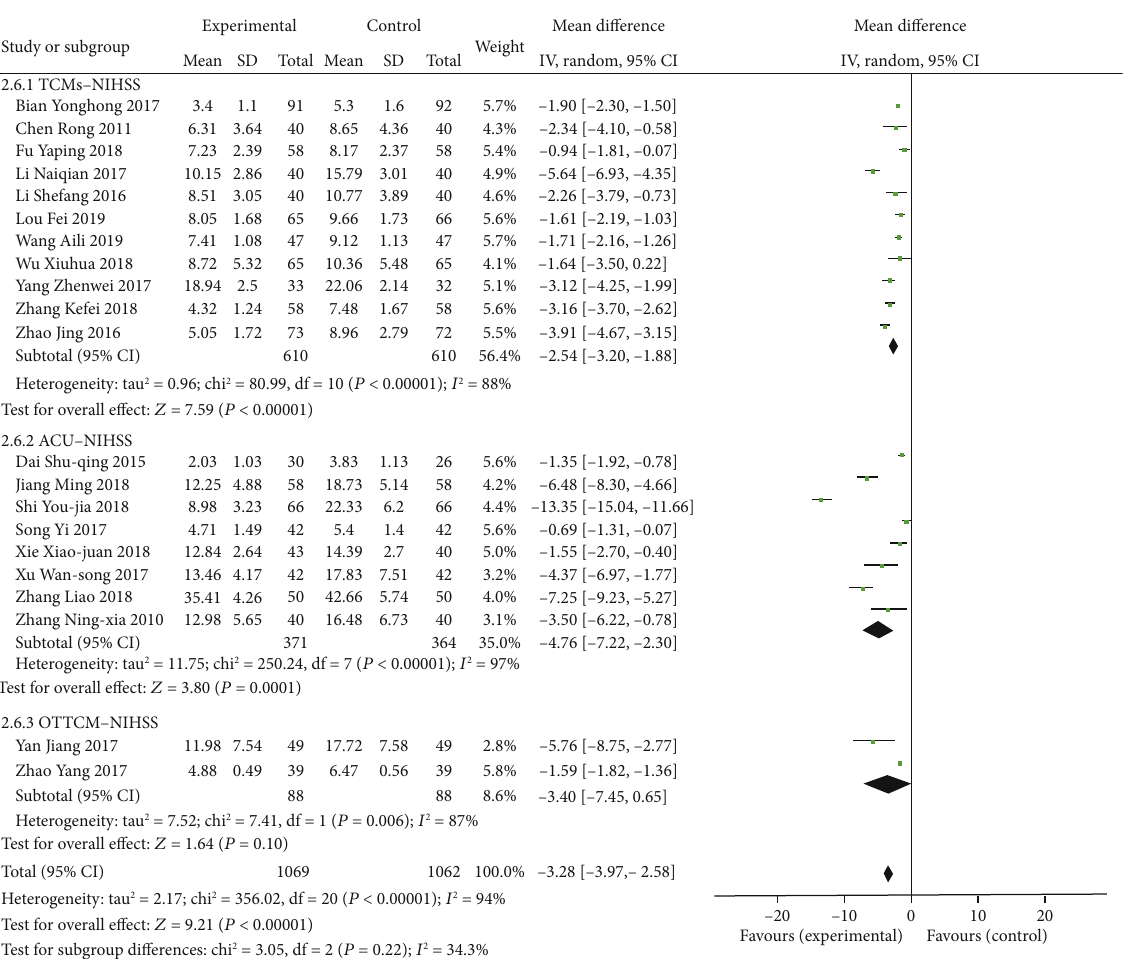
Figure 7: Forest plot of the NIHSS in patients treated with TCMs, ACU, or OTTCM combined with routine